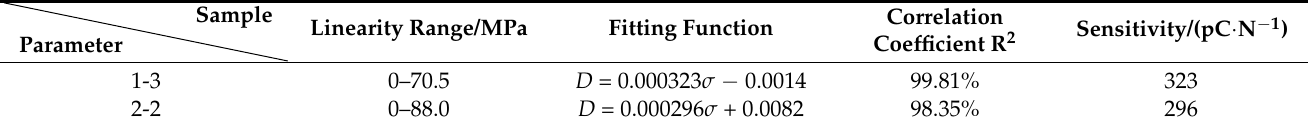
Figure 10. Calibration curve for dynamic sensitivity of the cement based piezoelectric composites. Table 2. Linear fitting parameters of dynamic